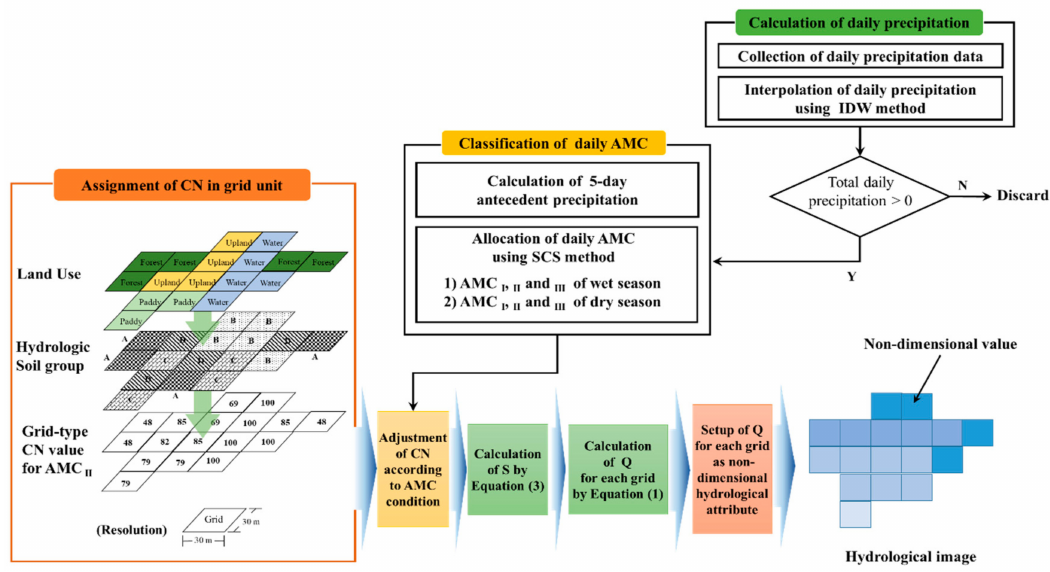
Figure 2. Schematic of hydrological image construction process.